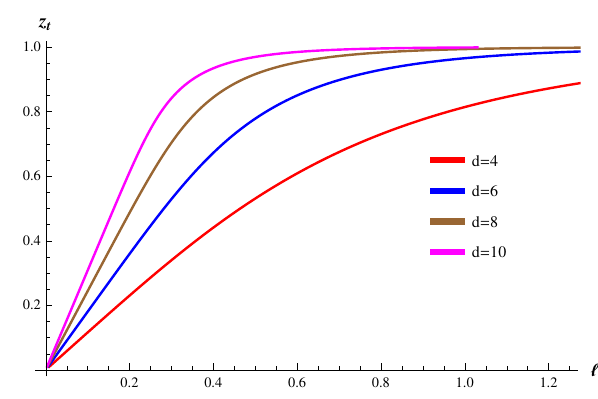
Figure 1. Plot of the turning point z t with respect to the width l for different values of the dimension d given a fixed ρ = 4 and z H = 1. This behavior indicates that the RT hypersurface extends deep inside the bulk geometry and hence gets close to the BH horizon for higher values of the